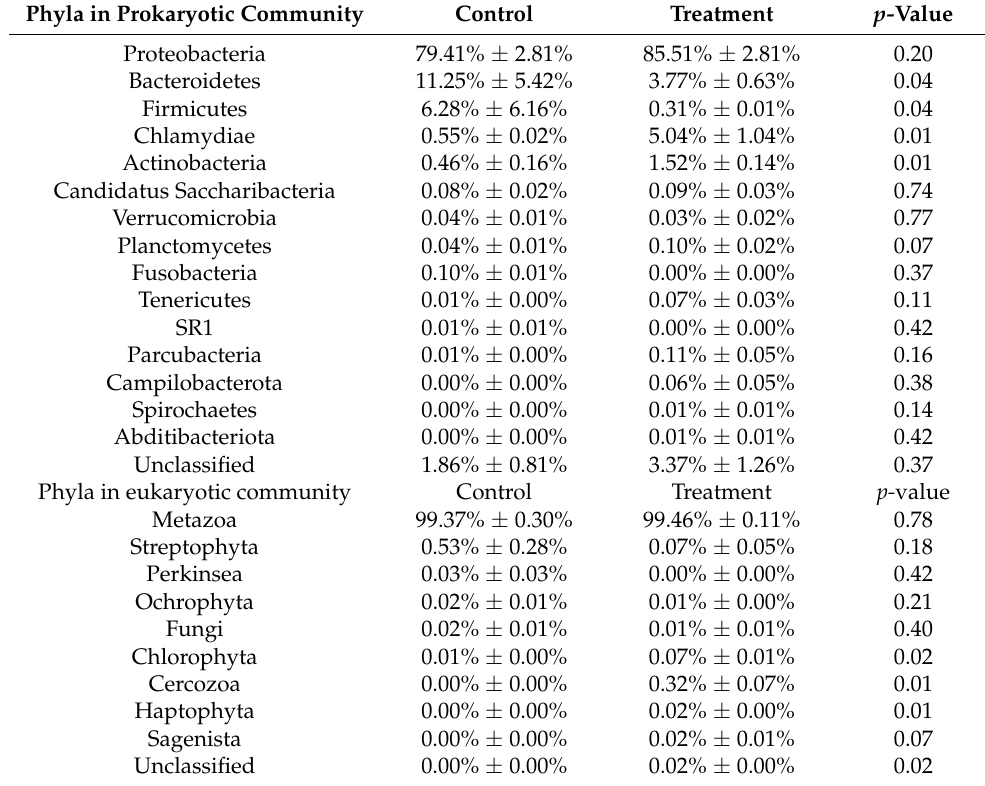
Table 3. Frequency distribution of prokaryotic and eukaryotic taxonomic profiles at the phylum level in control and treatment